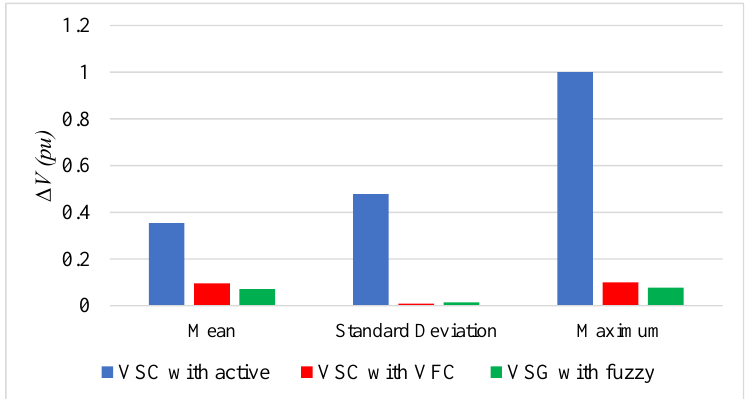
Figure 36. Voltage response statistics of the system for the scenarios presented in Section 4.3.